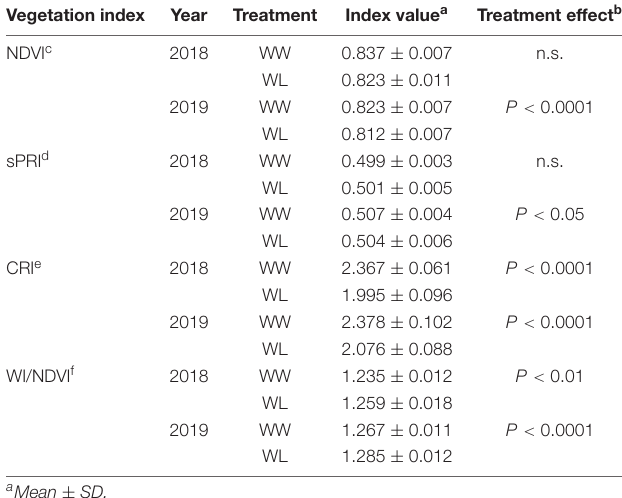
TABLE 2 | Reflectance-based vegetation indices calculated under well-watered (WW) and water-limited (WL) conditions in 2018 and 2019 in the 22 cotton accessions.